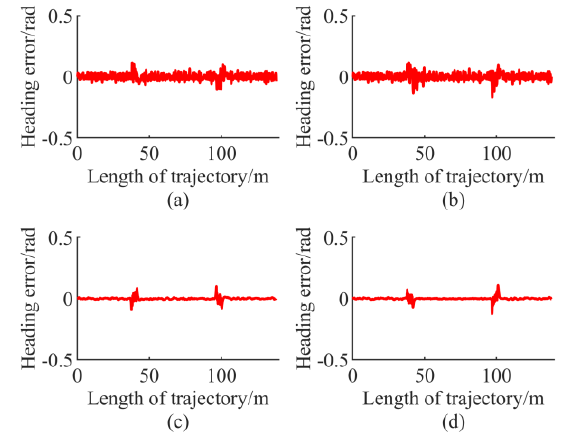
Figure 31. The heading error with the positioning error in ±0.1m. ( a ) LMPC. ( b ) LEMPC. ( c ) NMPC. ( d ) NEMPC.